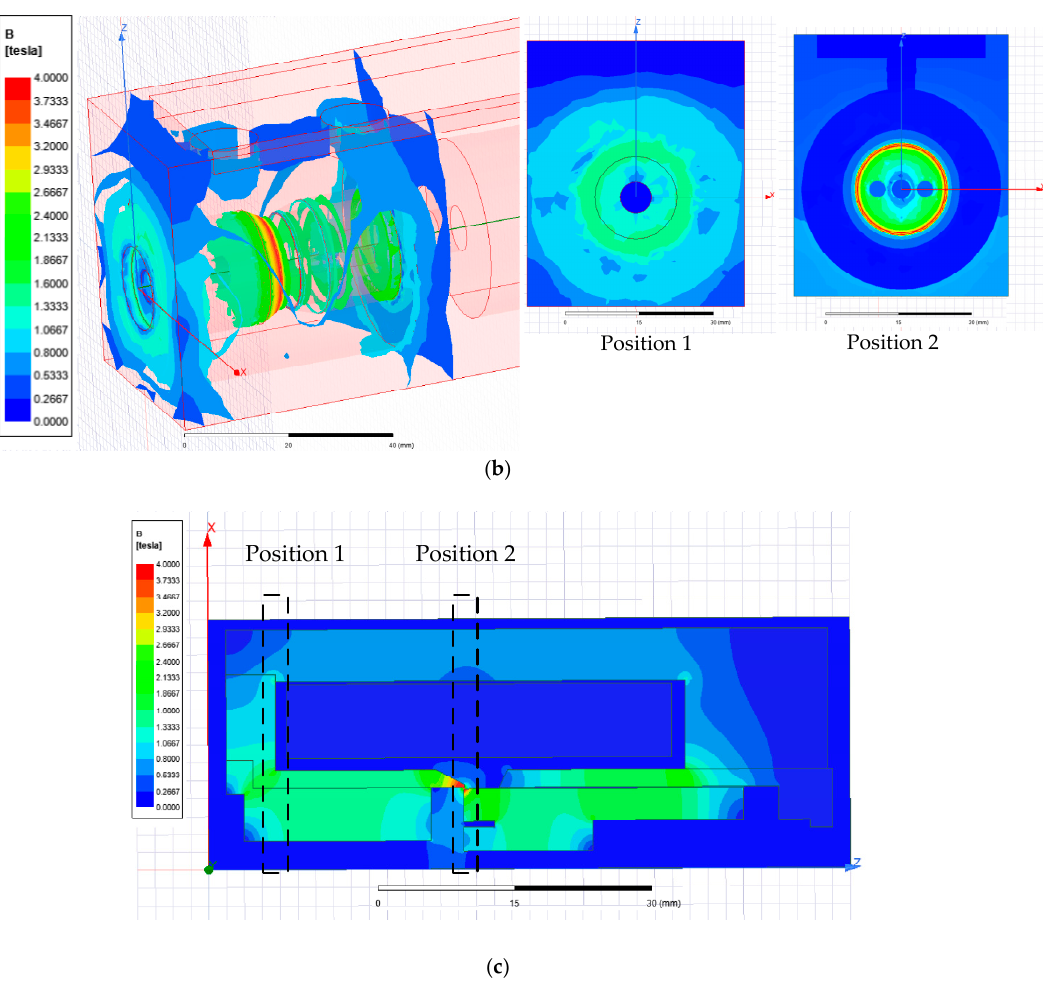
Figure 4. Verification of simplified 2D FEA model: ( a ) push force comparison; ( b ) flux density field result of the 3D FEA model; ( c ) flux density field result of the 2D FEA model.